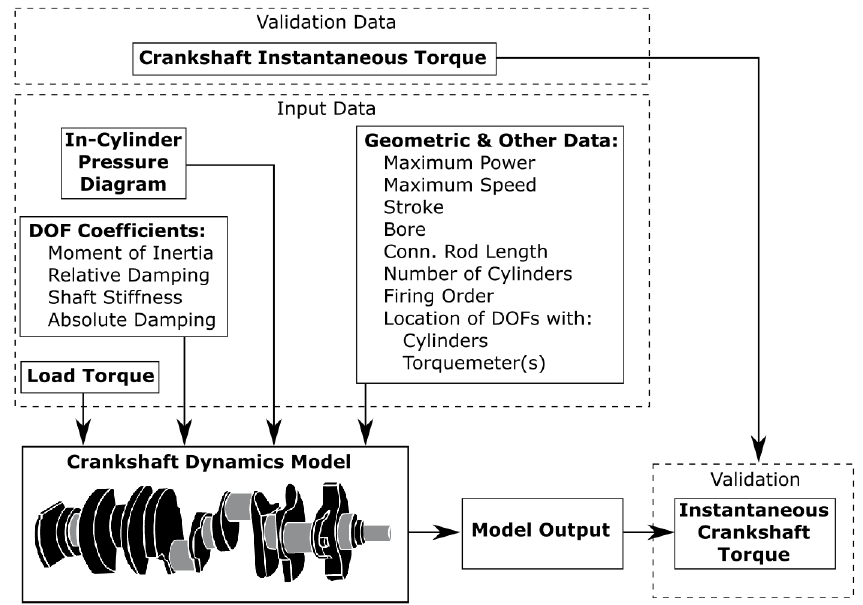
Figure 4. Engine crankshaft dynamics model input and output